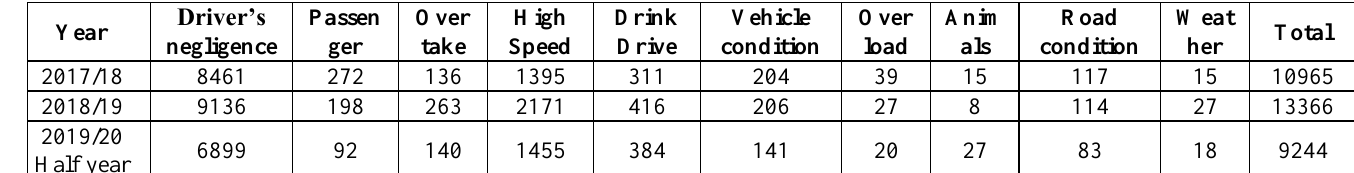
Figure 17: Accidents with respect to time. Table 26: Accidents with respect to cause of accident.